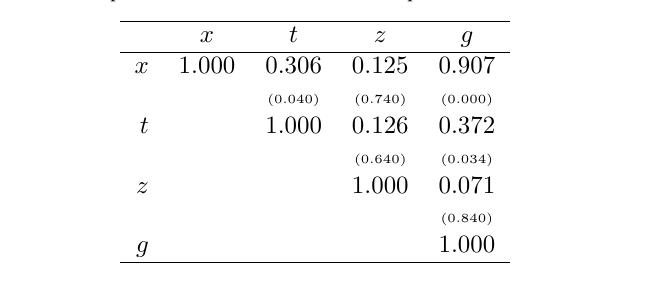
Maximal local correlation statistics. In brackets two-sided p values evaluated via permutation test with 1000 replications.